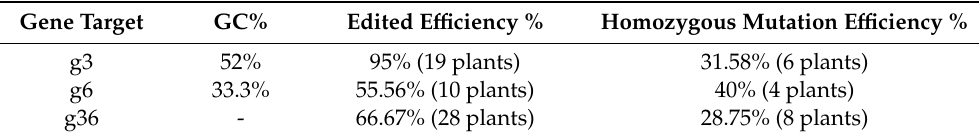
Table 1. Editing e ffi ciency of each